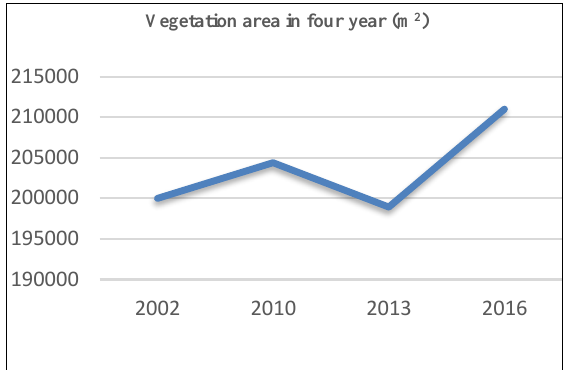
Figure 2. the Uninhabited Islands and Sandbars